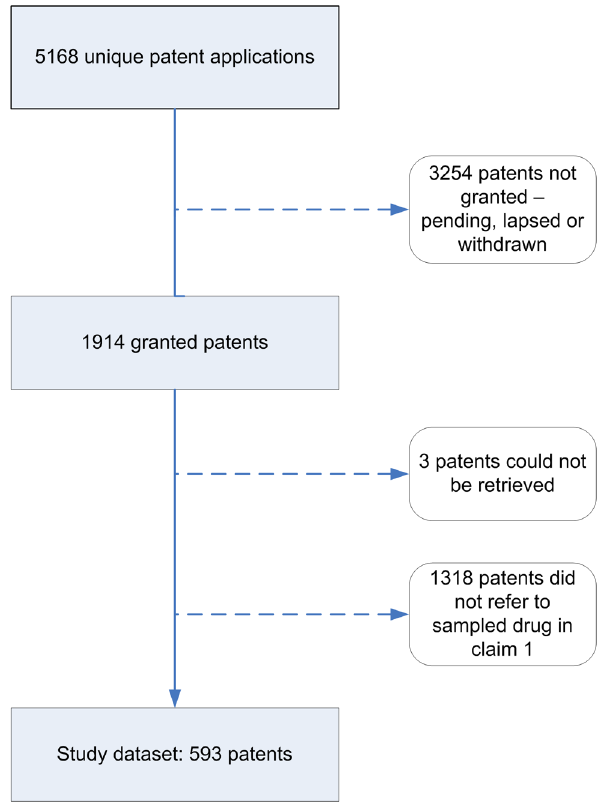
Figure 1. Identification of patents associated with high-cost drugs in the study sample. This flow chart shows the derivation of the patents associated with the drugs in our sample. The patents were selected by first identifying all unique patent applications that mentioned one of the high-cost drugs in our sample. There were found to be 5168 such applications in Australia, of which 3254 had not proceeded to grant – either because the application was pending, had lapsed or had been withdrawn. Of the remaining 1914, we could retrieve the specifications of all but three. Of the 1911 patent specifications analysed, 1318 had a claim 1 that did not read onto the API of a drug from the sample – leaving 593 unique patents associated with the drugs in our